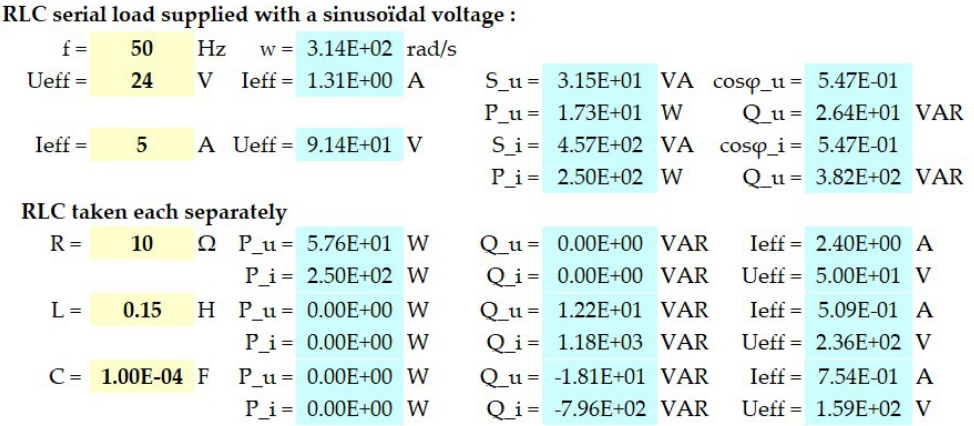
Figure 2. Results obtained with the RLC series circuit calculating